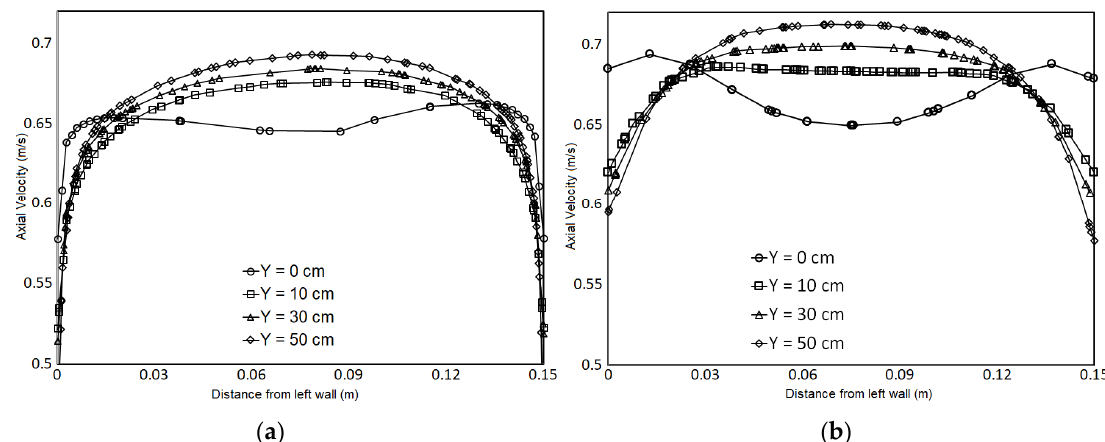
Figure 7. Axial velocity profiles obtained at the horizontal mid-section of the observation chamber taken at different distances Y from the entrance obtained using ( a ) Global Mesh refinement and using “Normal” scheme (Model B4) and ( b ) Partial Refinement method (Model F).